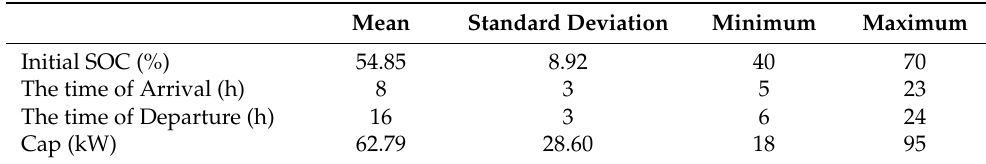
Table 2. The modified probability distribution of EVs [31].